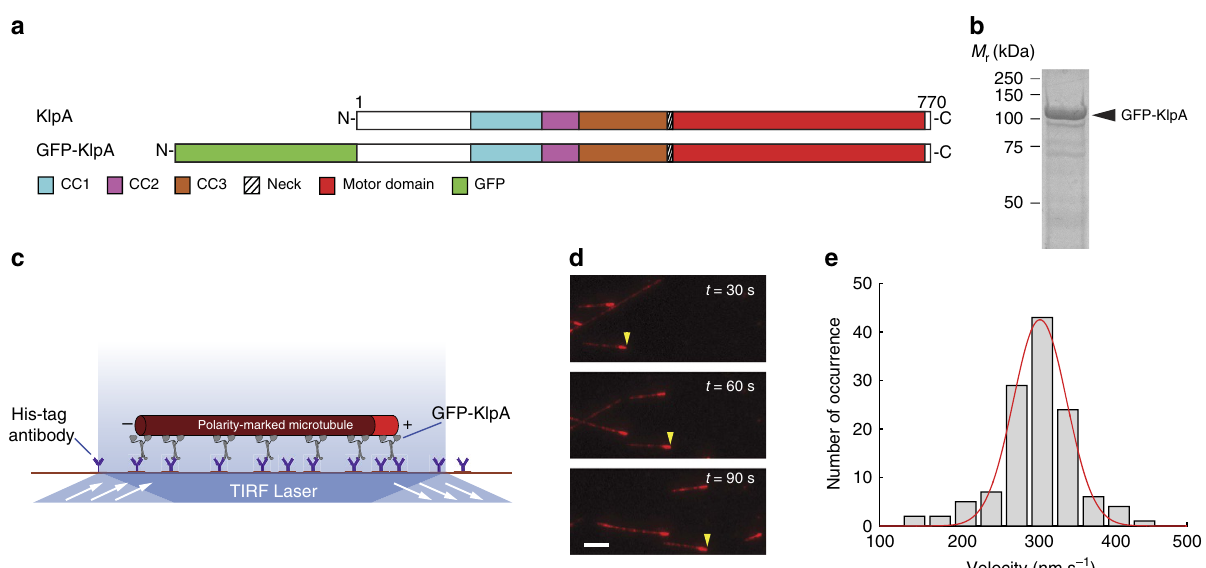
Figure 1 | Surface-immobilized KlpA molecules exhibit minus end-directed motility to glide microtubules. ( a ) Schematic diagrams of the full-length KlpA and the recombinant GFP-KlpA. The full-length KlpA consists of three consecutive coiled coils (CC1, aa 153–249; CC2, aa 250–297; and CC3, aa 298–416), a neck (aa 417–421) and a catalytic microtubule-binding motor domain (aa 422–756). GFP-KlpA contains an N-terminal polyhistidine-tag (not shown). ( b ) Coomassie-stained SDS–polyacrylamide gel electrophoresis (SDS–PAGE) of purified recombinant GFP-KlpA. ( c ) Schematic diagram of the microtubule-gliding assay. Movement of microtubules driven by surface-immobilized GFP-KlpA molecules was visualized by TIRF microscopy. Microtubules were fluorescently labelled with tetramethylrhodamine (TMR), and polarity-marked with a dim minus end and a bright plus end. ( d ) Representative TIRF microscopy images of polarity-marked microtubules moving on the coverslip surface with the bright plus ends leading (yellow arrowheads). ( e ) Histogram showing the microtubule-gliding velocity distribution of GFP-KlpA. Red line indicates a Gaussian fit to the velocity histogram. Scale bar, 5 m